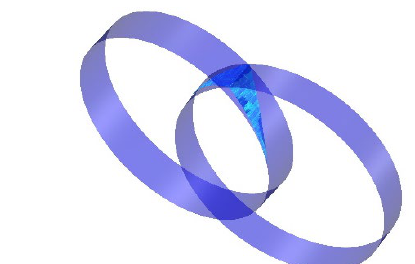
Figure 4: Search for the best cylinder for the webs.